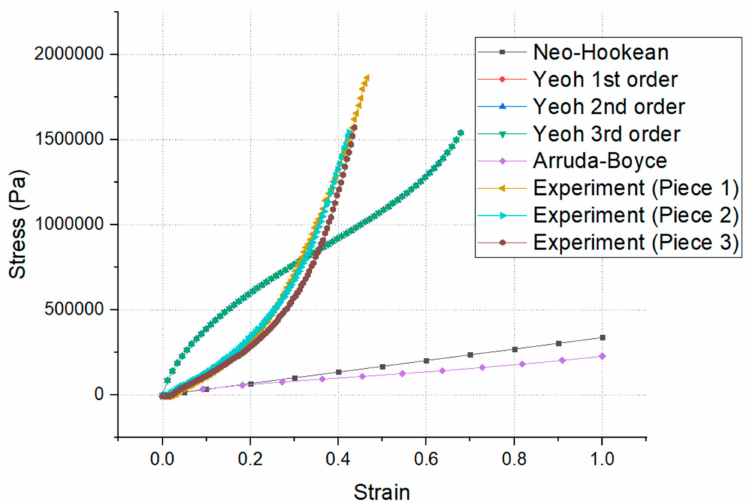
Figure 12. Comparison of the FEM and experimental curves for the hyperelastic